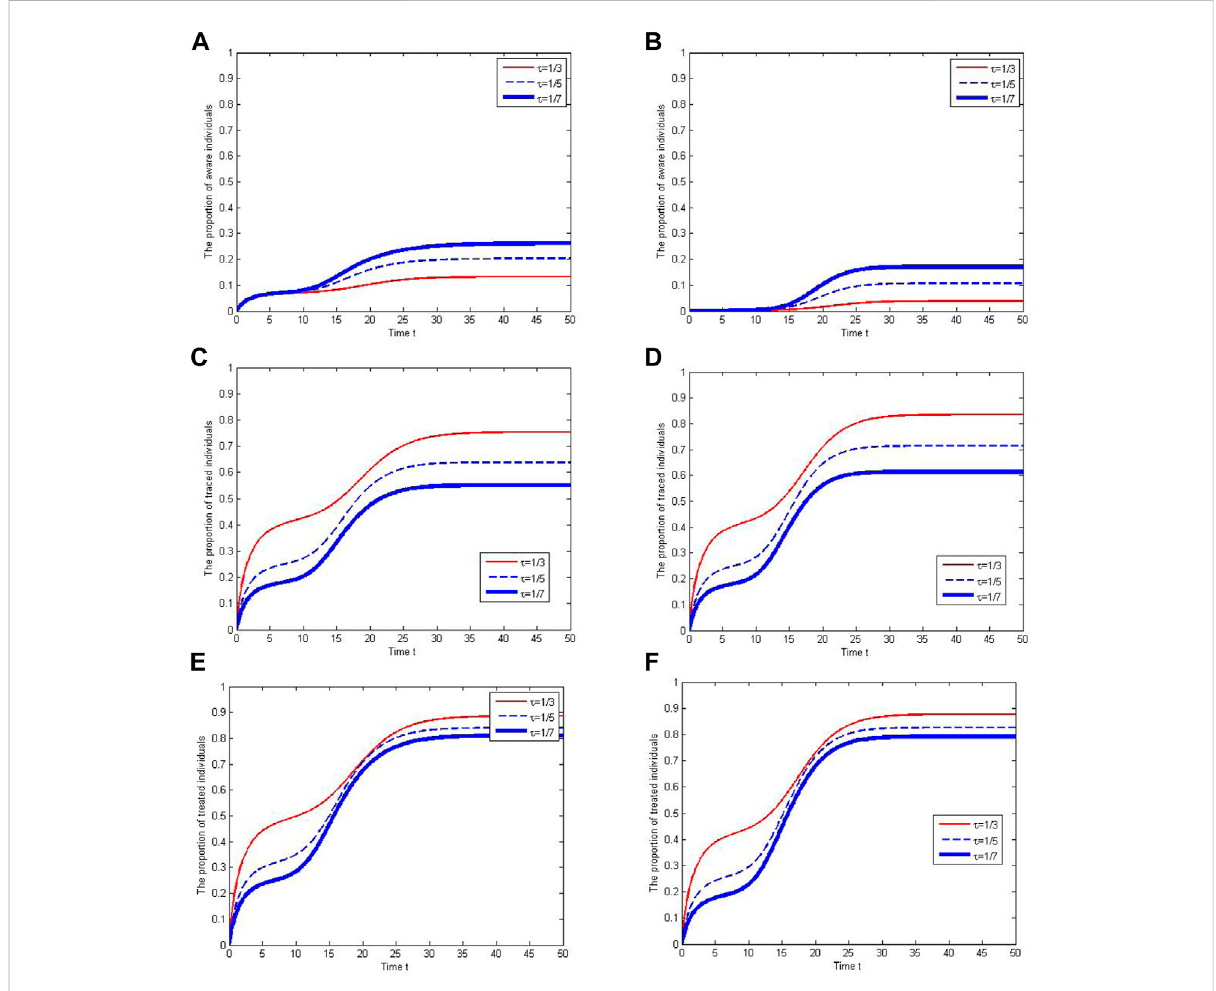
FIGURE 6 The cumulative proportions of aware and traced individuals under different tracing rates and awareness processes. In (A) , (C) and (E) , the awarenessprocessfollowstheuniformdistribution, U (0,20).In (B) , (D) and (F) ,theawarenessprocessfollowsthegammadistribution, Gamma (10,1). Treated individuals refer to aware individuals and traced